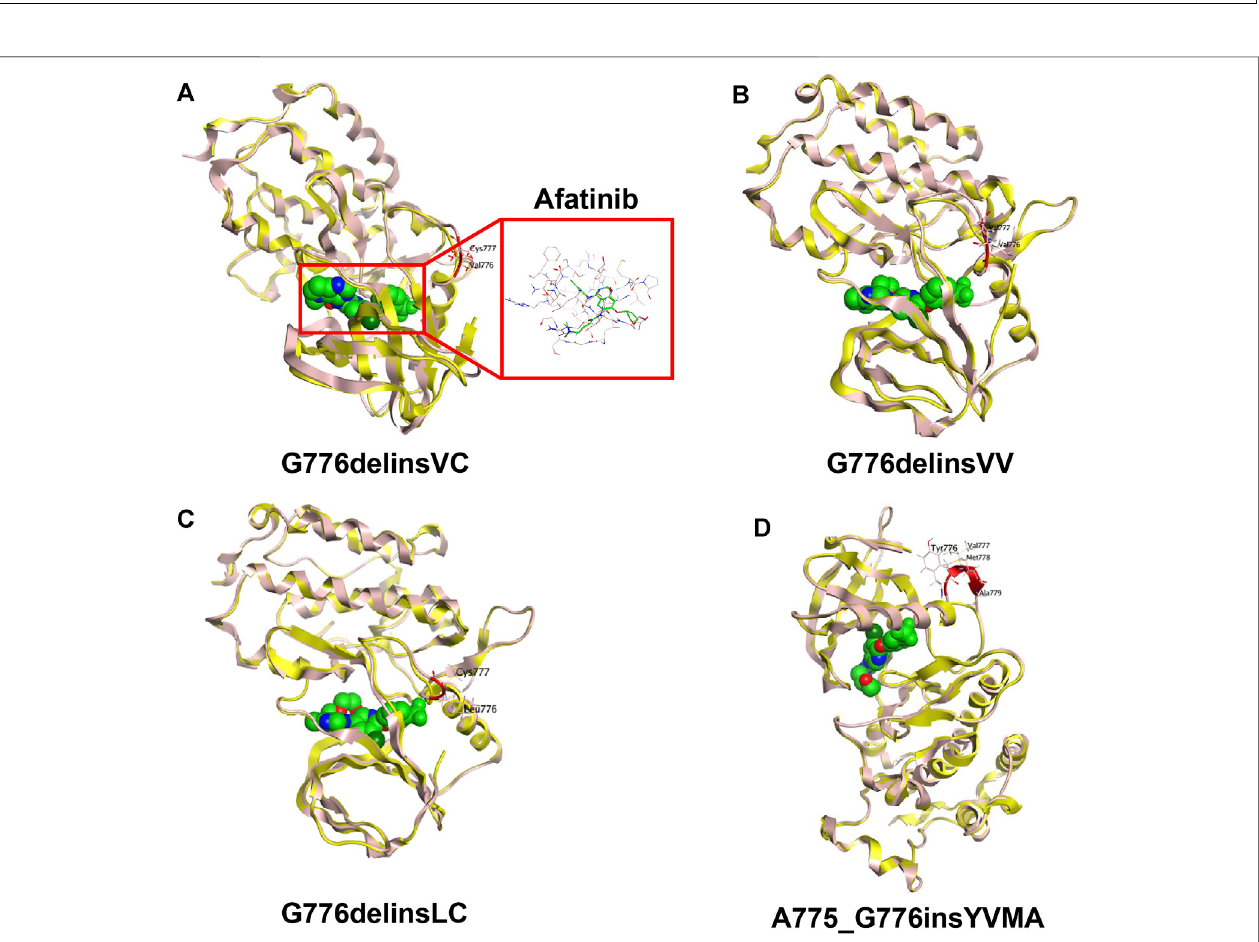
Frontiers in Pharmacology |